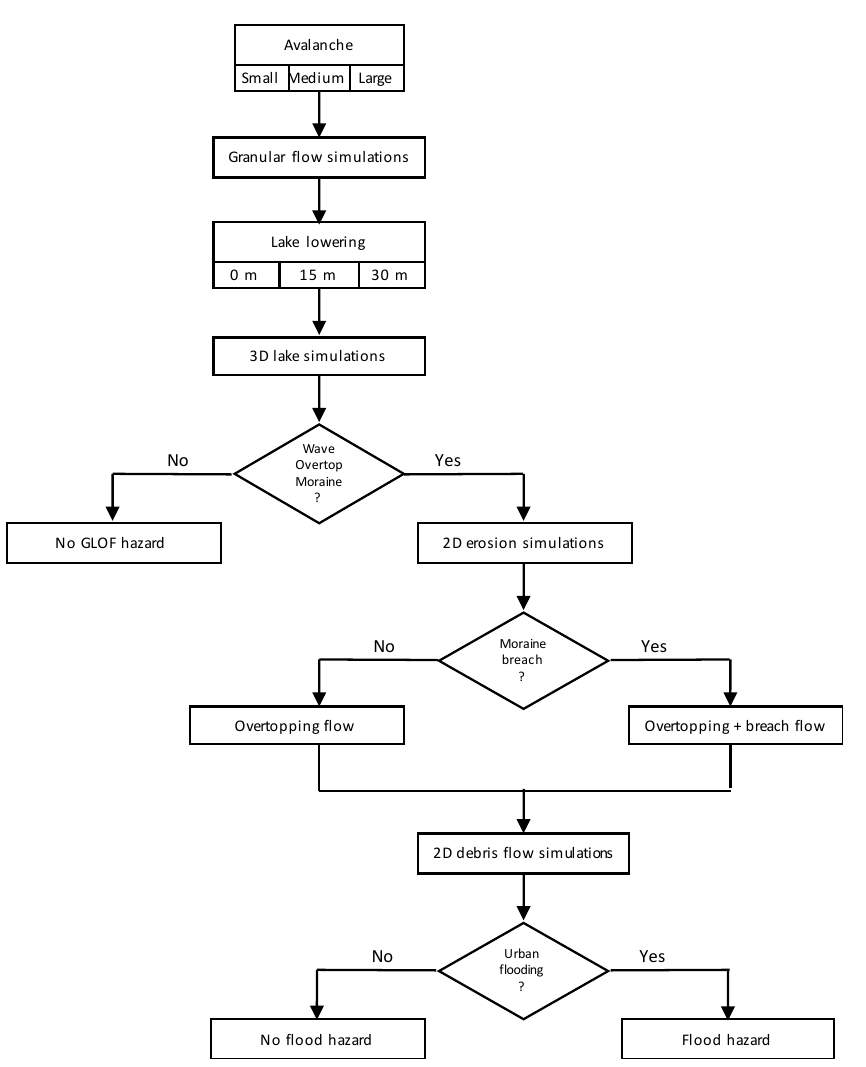
Figure 2. Flowchart of the hazard process chain for an avalanche-triggered GLOF from a glacial lake to assess potential downstream